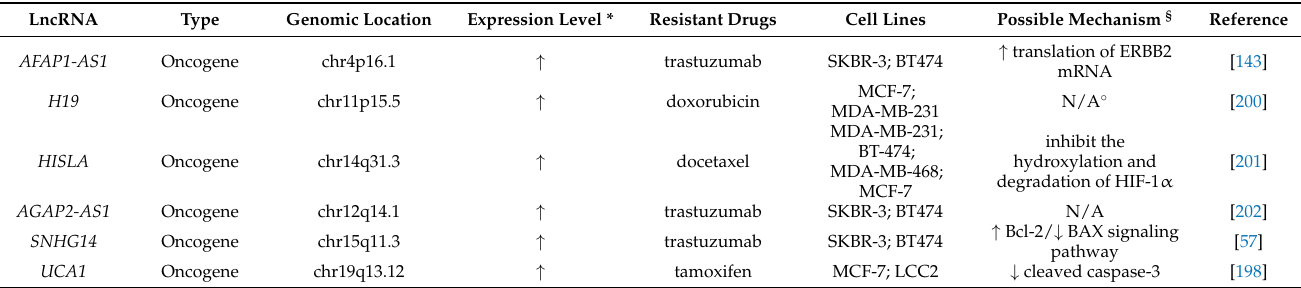
Table 3. The role of exosomal lncRNAs in drug resistance in breast